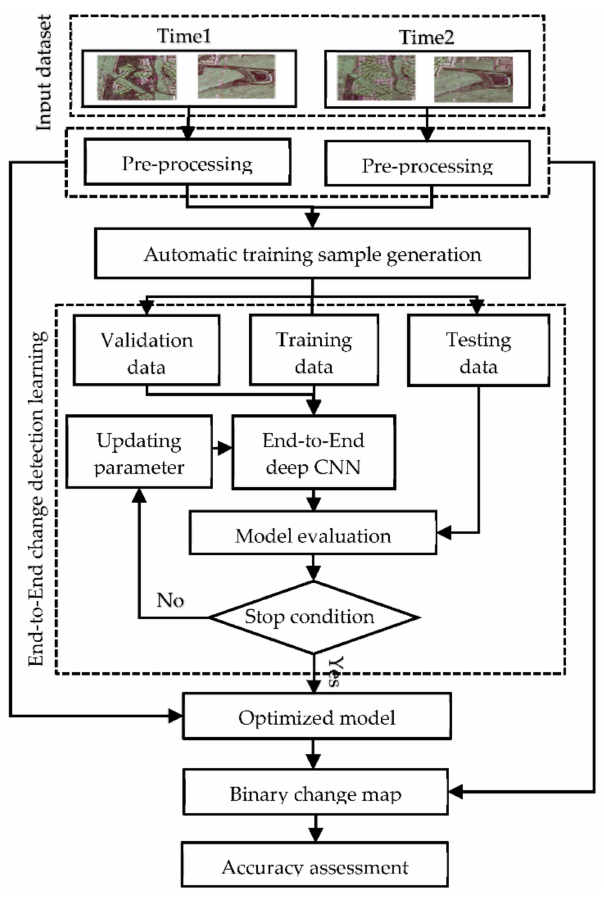
Figure 1. General scheme of the proposed unsupervised binary change detection (CD) method. CNN is convolutional neural